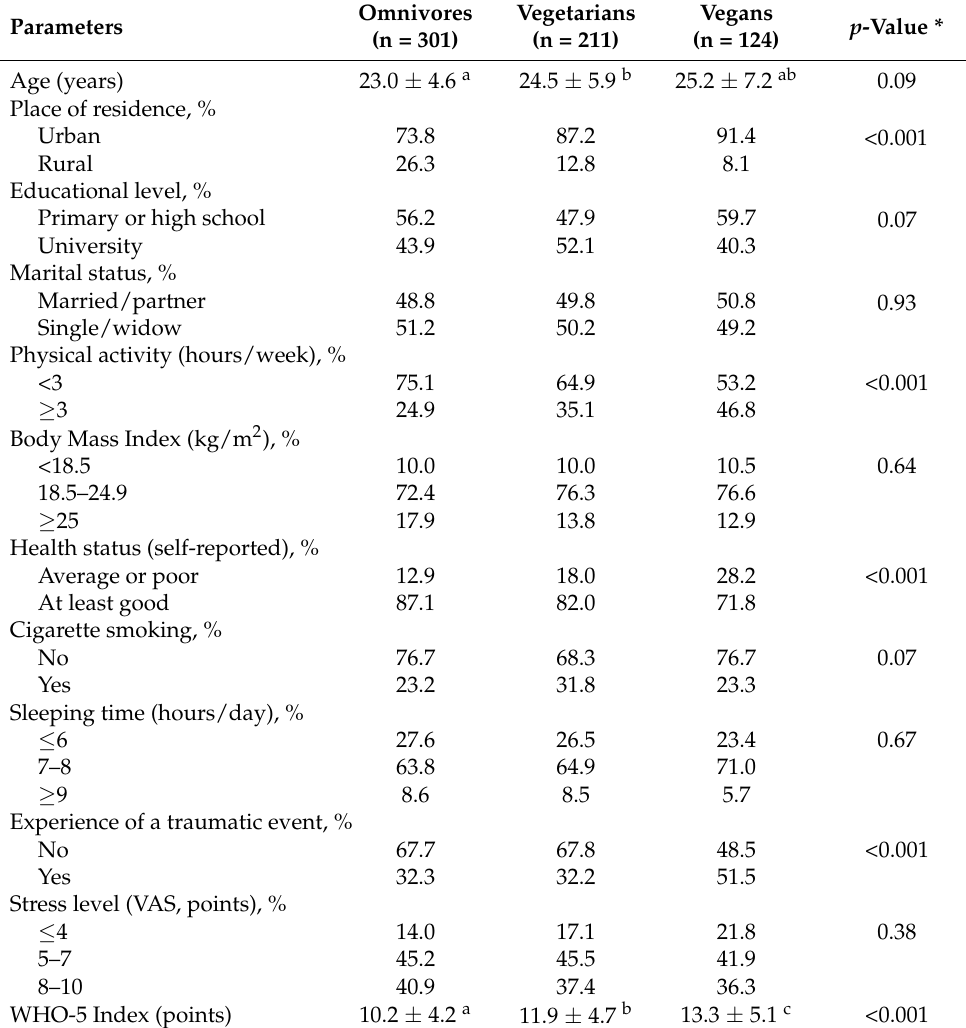
Table 1. Characteristics of women by type of diet